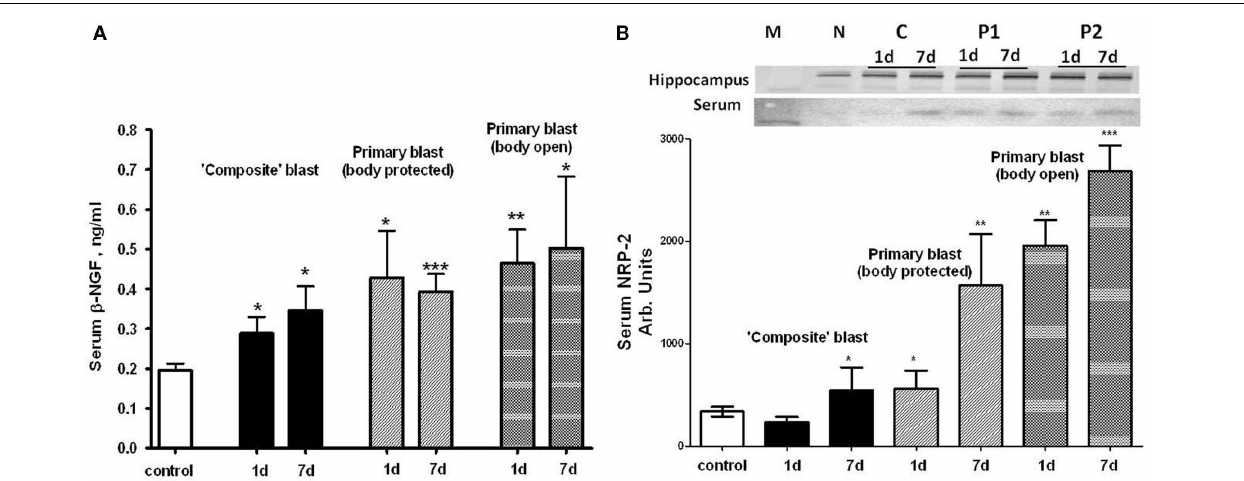
FIGURE 10 | Blast-induced accumulation of β -NGF and Neuropilin-2 in rat serum. (A) Serum β -NGF after different types of blast (SW ELISA); (B) serum Neuropilin-2 detection by antibody arrays. Inset: representative western blots for hippocampus and serum. (N, naïve; C, “composite”; P1, primary/head; P2,